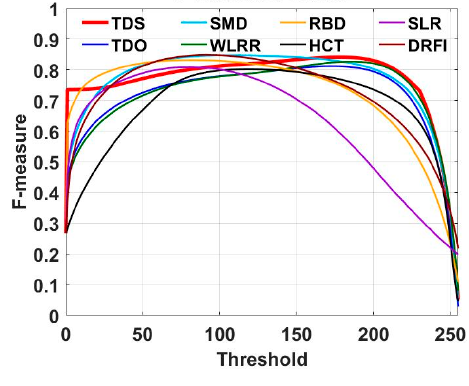
Figure 3. Quantitative comparison on three datasets in terms of F-measure curve. ( a ) F-measure comparison on iCoSeg dataset; ( b ) F-measure comparison on ECSSD dataset; ( c ) F-measure comparison on MASRA10K dataset.